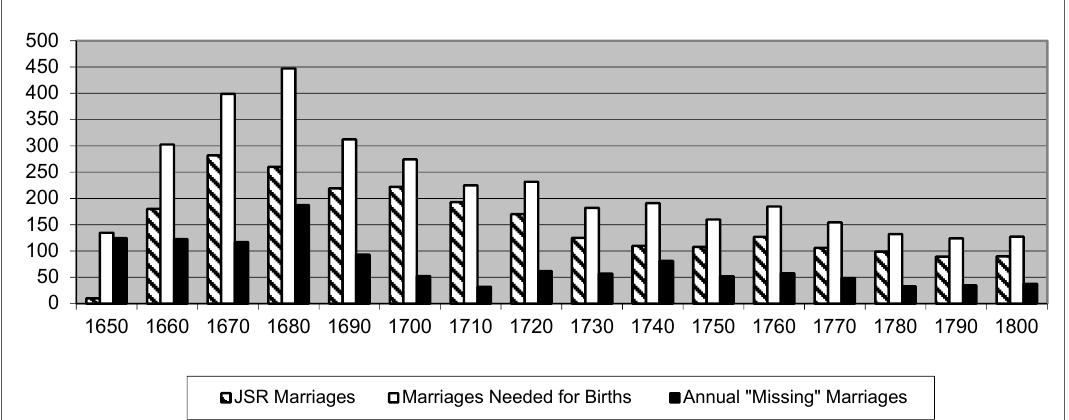
Figure 3. “Missing Marriages”: comparison of annual marriages (from BpM for L&M QM) and Rowntree.